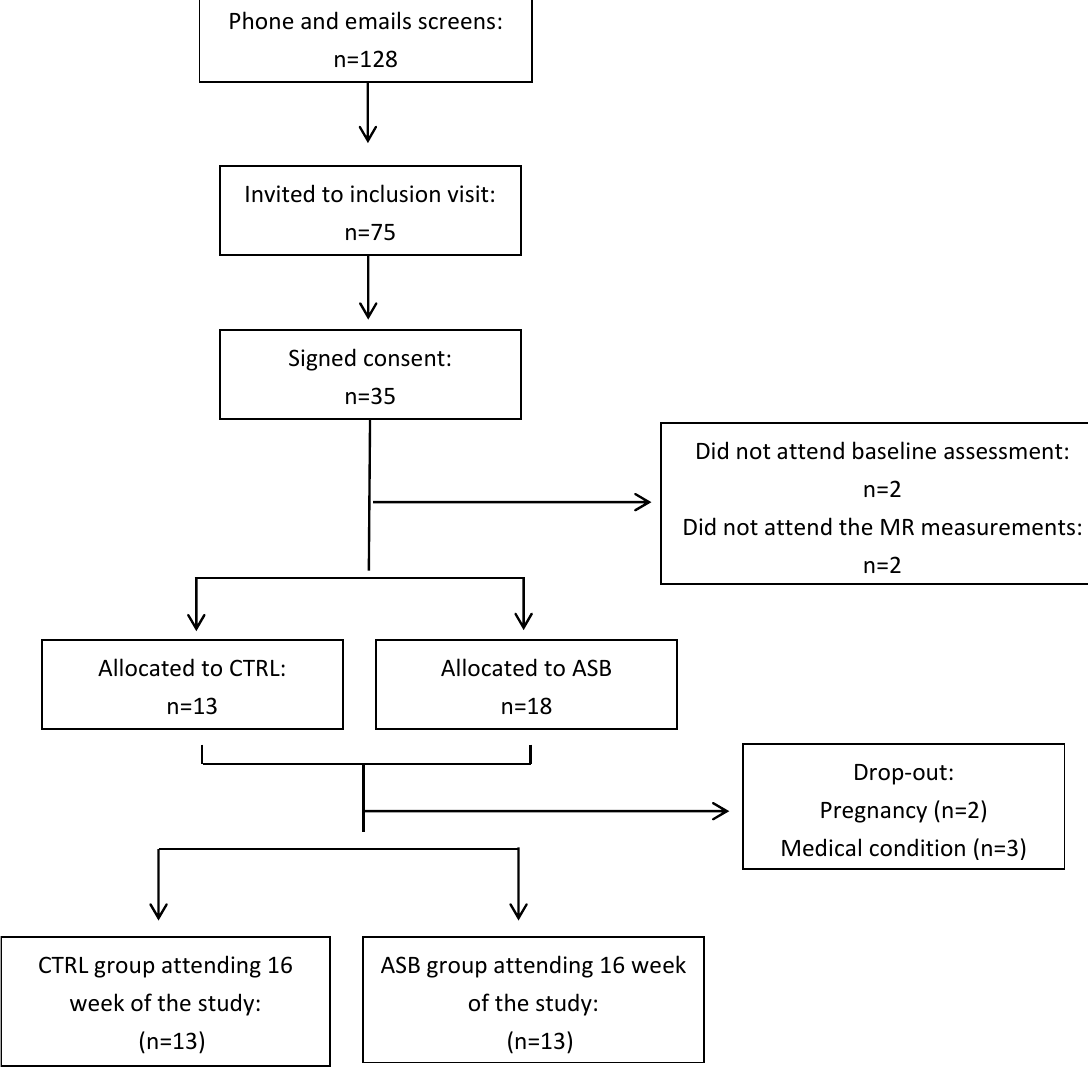
Figure 1. Eligibility, enrollment, randomization, and follow ‐ up of study participants.